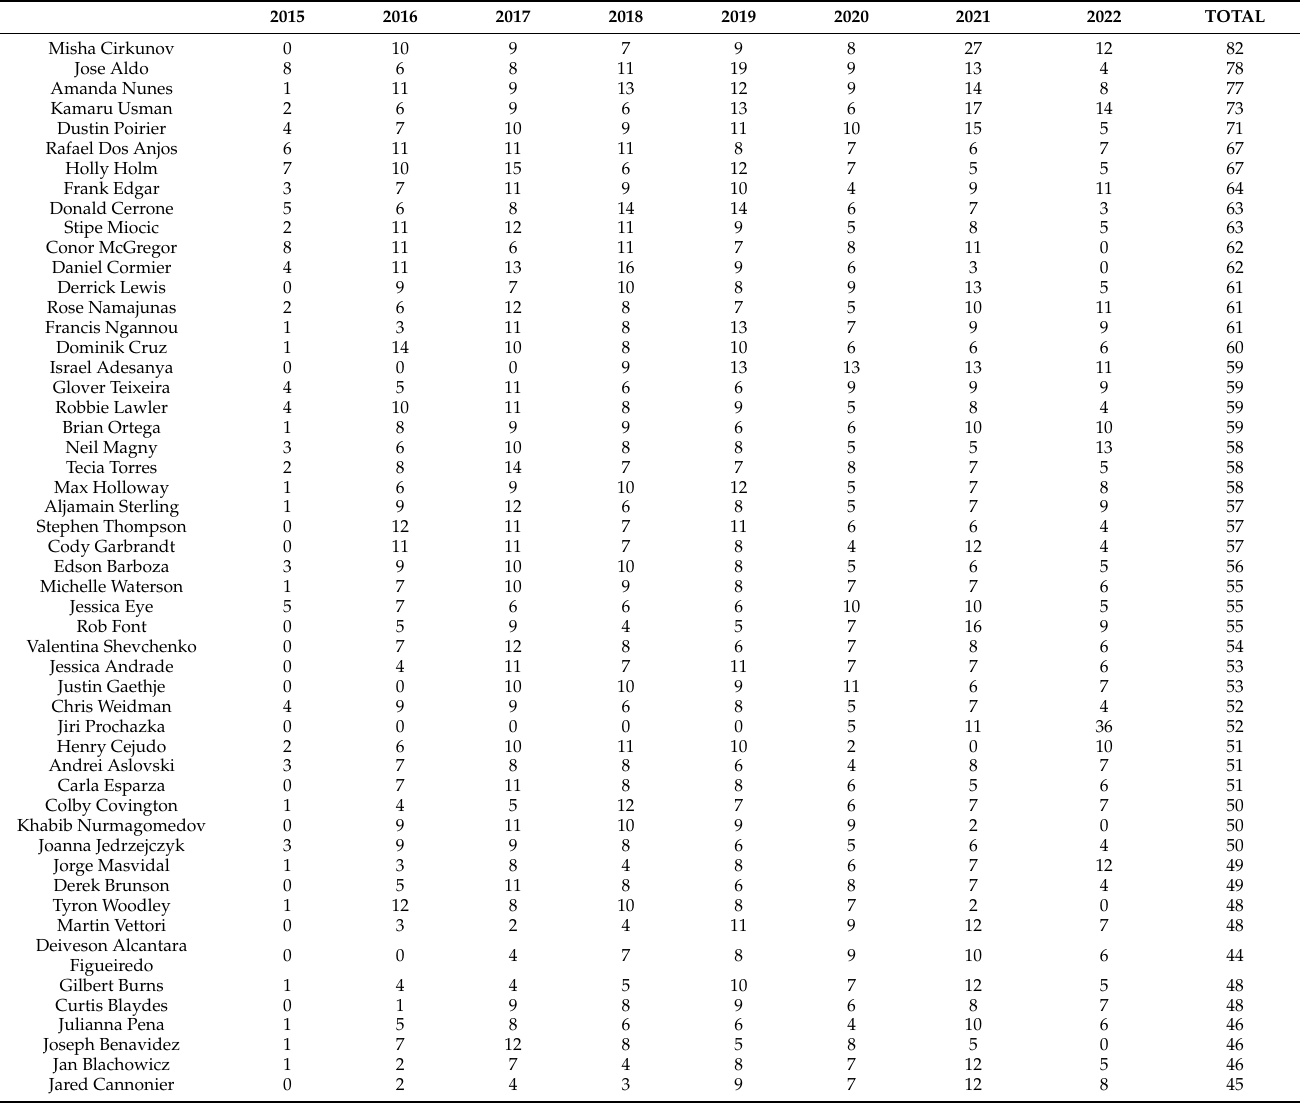
Table 2. Number of negative tests for anti-doping violations in top-rank